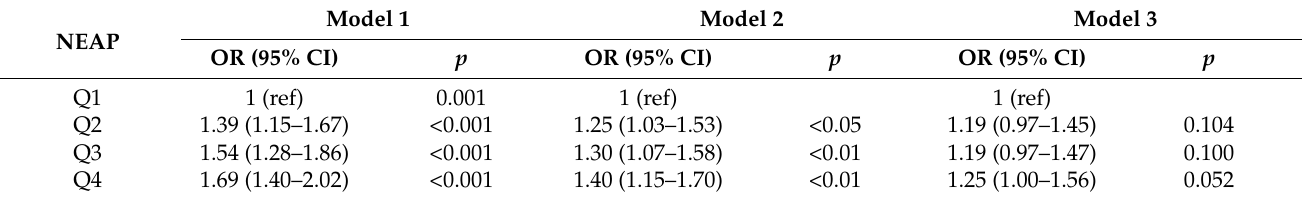
Table 4. Odds ratios (ORs) and 95% confidence intervals (CIs) for hyperuricemia risk based on